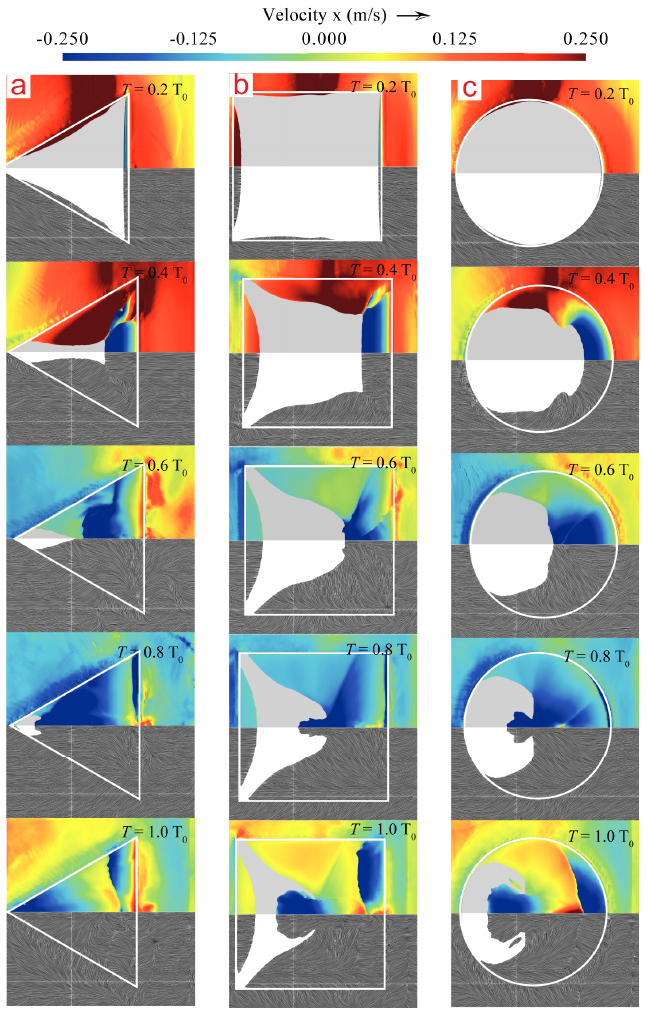
Figure 14. Distribution of fluid velocity around ice floes. ( a ) Triangle ice floe; ( b ) Square ice floe; ( c ) Circle ice